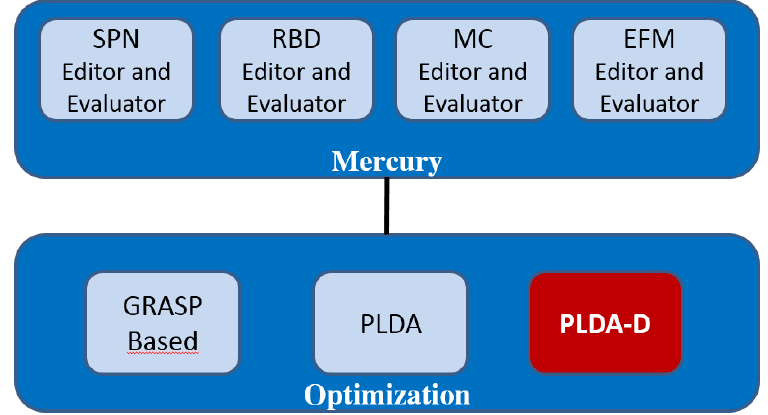
Figure 9. Evaluation environment. SPN, stochastic Petri nets; RBD, reliability block diagrams; EFM, energy-flow models. PLDA-D, power load distribution